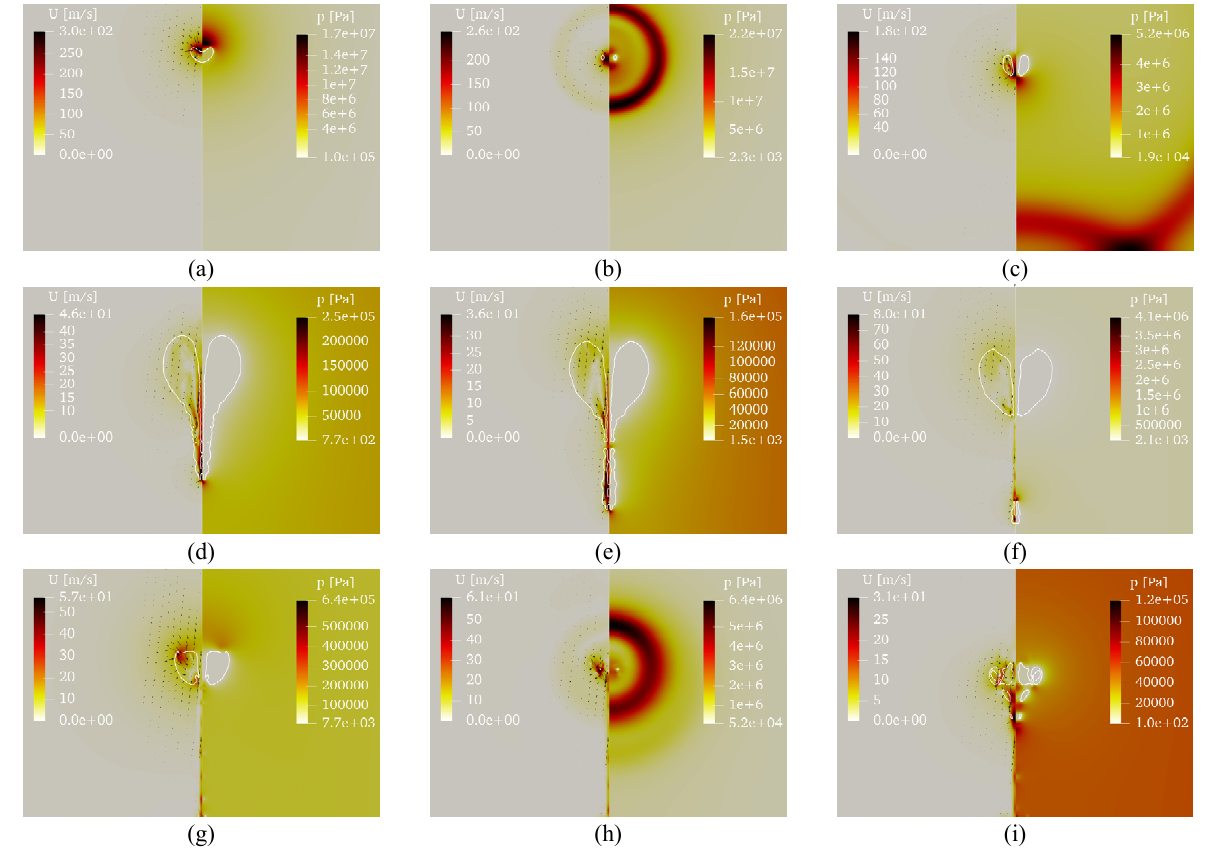
Figure 8. Velocity (left-hand side) and pressure (right-hand side) fields during the process of multi- period cavitation collapse when γ = 2.5. ( a ) 𝑡 ∗ = 1.069, ( b ) 𝑡 ∗ = 1.076, ( c ) 𝑡 ∗ = 1.090, ( d ) 𝑡 ∗ = 1.492, ( e ) 𝑡 ∗ = 1.721, ( f ) 𝑡 ∗ = 1.865, ( g ) 𝑡 ∗ = 2.008, ( h ) 𝑡 ∗ = 2.080, and ( i ) 𝑡 ∗ = 2.295.